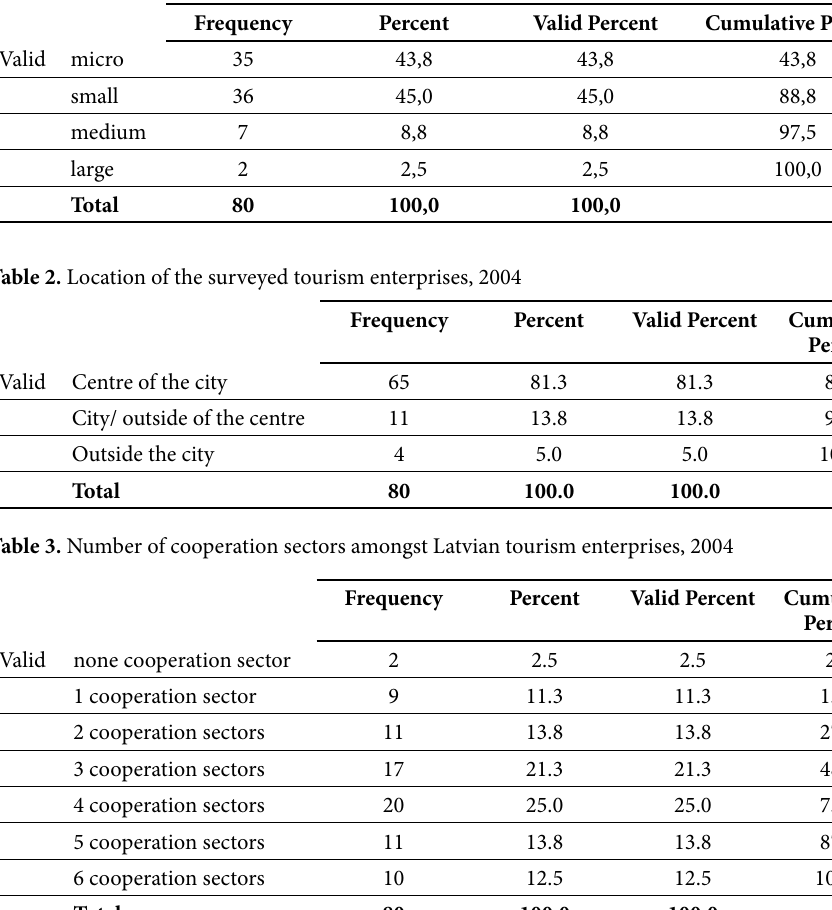
Table 1. Frequencies of the size of the surveyed Latvian tourism enterprises, 2004